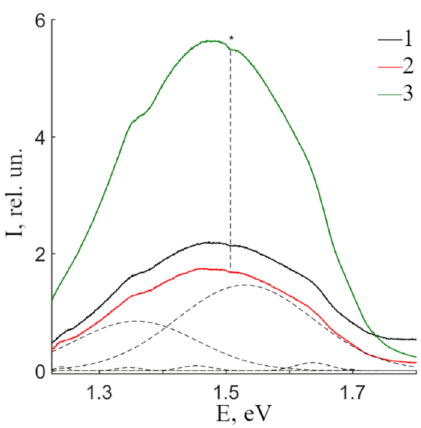
Figure 7. PL spectra of CLN (1), SLN (2) and SLN (6.0 wt% K 2 O) (3) crystals in the near-IR region. * denotes a dip at 1.5 eV in all presented spectra.